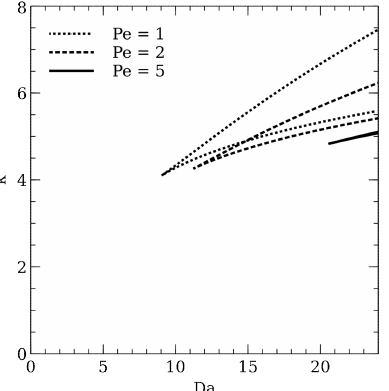
Figure 5. Catastrophic plots for different Pe numbers. The change of the cusp bifurcation point